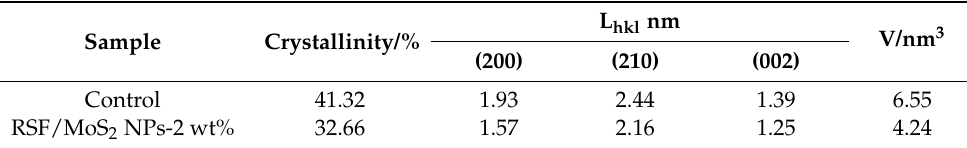
Table 2. Structural parameters of RSF/MoS 2 NPs hybrid fibers.